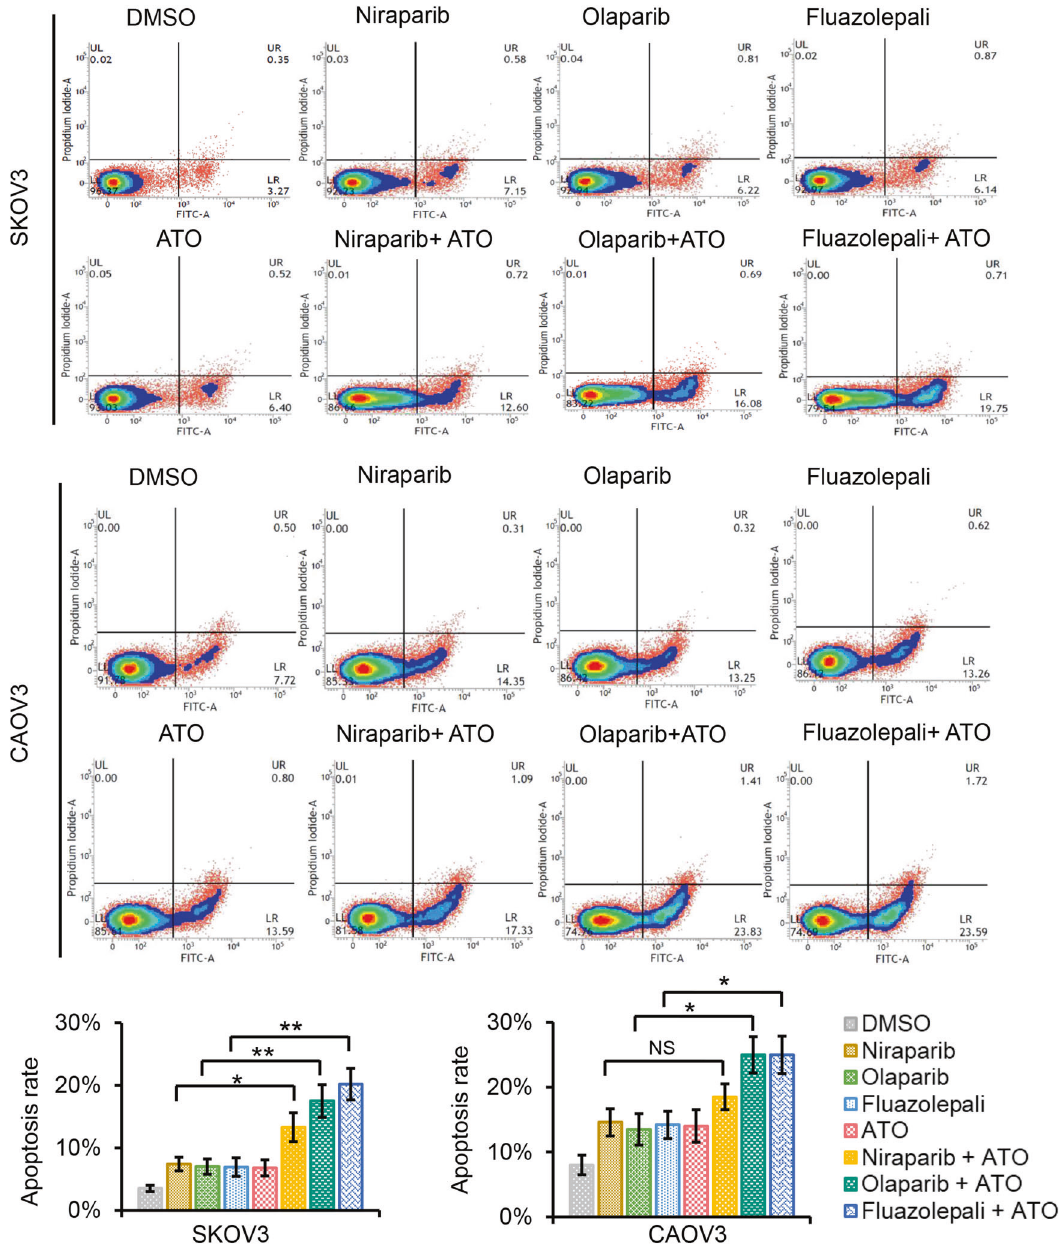
Fig. 4 Cooperative treatment effects of ATO and PARP inhibitors on cell apoptosis in SKOV3 and CAOV3 cells. ATO and PARP inhibitors, niraparib, olaparib, or fl uazolepali, cooperatively induced apoptosis of SKOV3 and CAOV3 cells. Cells were treated with DMSO, ATO, niraparib, olaparib, fl uazolepali, combination of ATO and niraparib, combination of ATO and olaparib, or the combination of ATO and fl uazolepali for 48 h, followed by FACS analysis of cell apoptosis with annexin V and PI staining. We used the IC50 of each drug for this experiment. Representative images of three biologically independent experiments. Error bars represent mean ± SD. NS not signi fi cant; * P < 0.05; ** P <